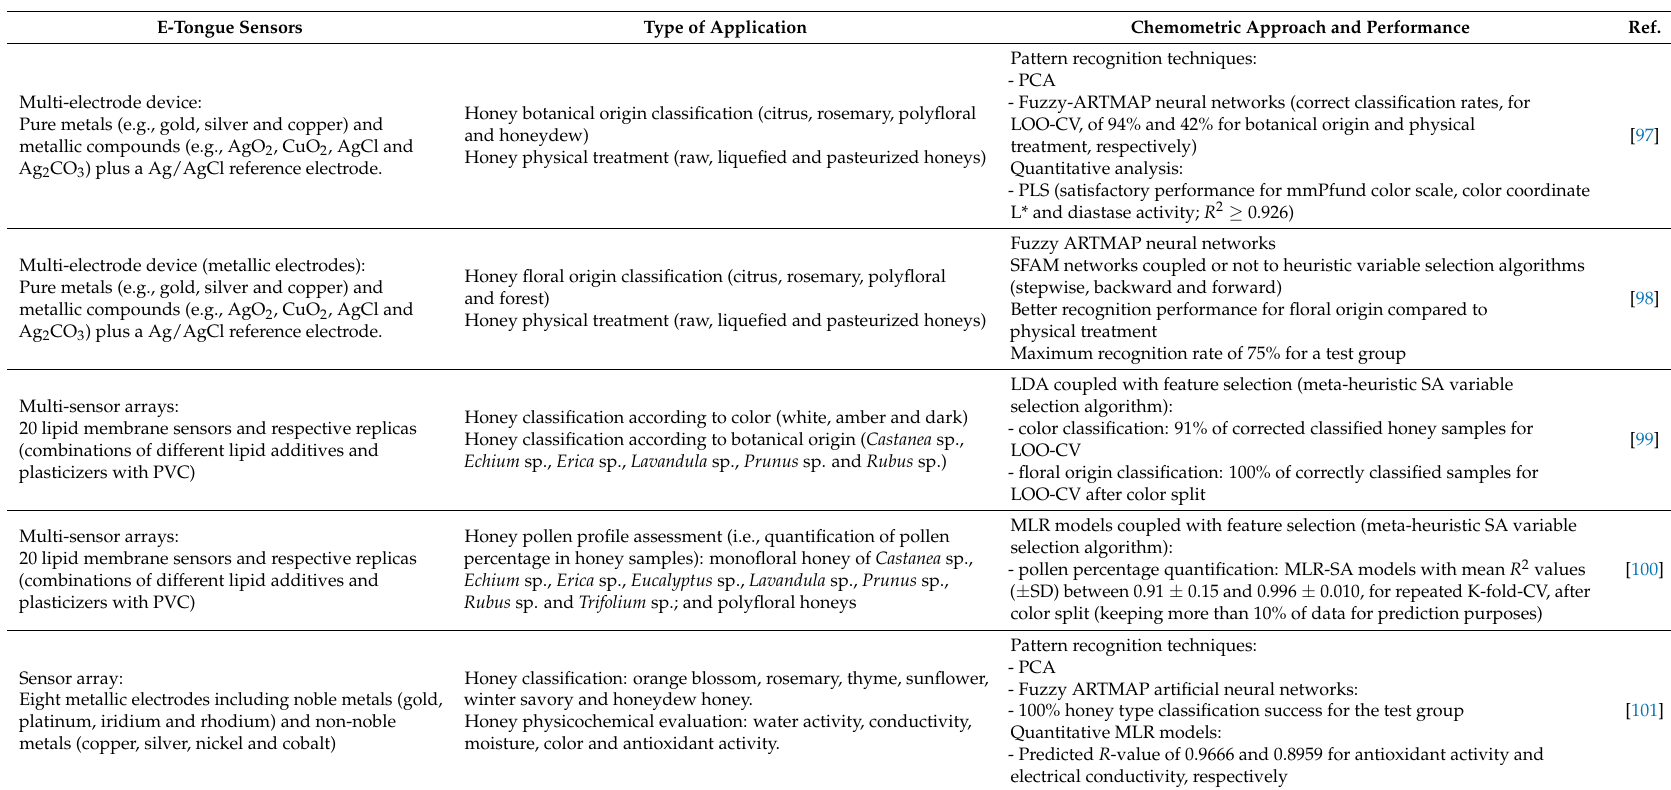
electrical conductivity,